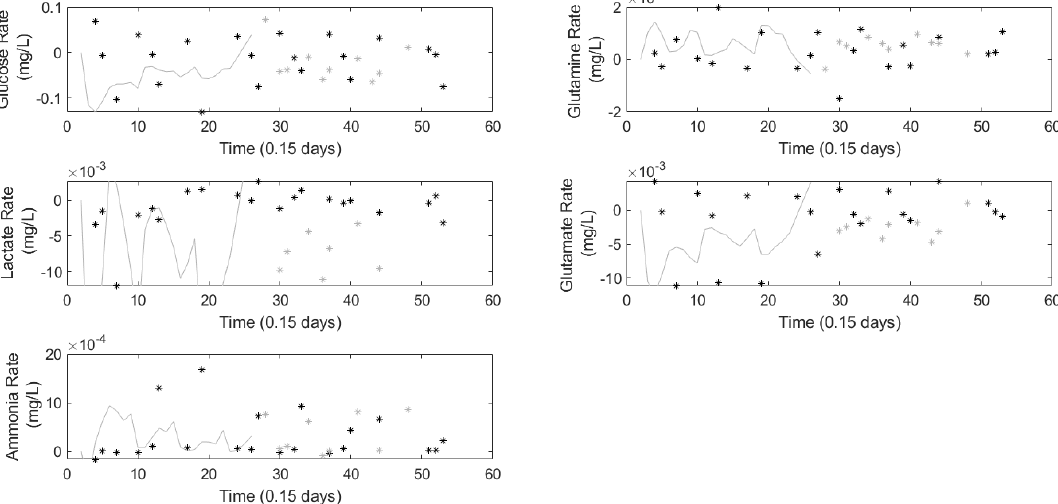
Figure 7. The process data (black) is compared with the metabolite rate model predictions using the state observer (grey solid) until the states converge and then the metabolite rate model predicts the remainder of the validation batch (grey